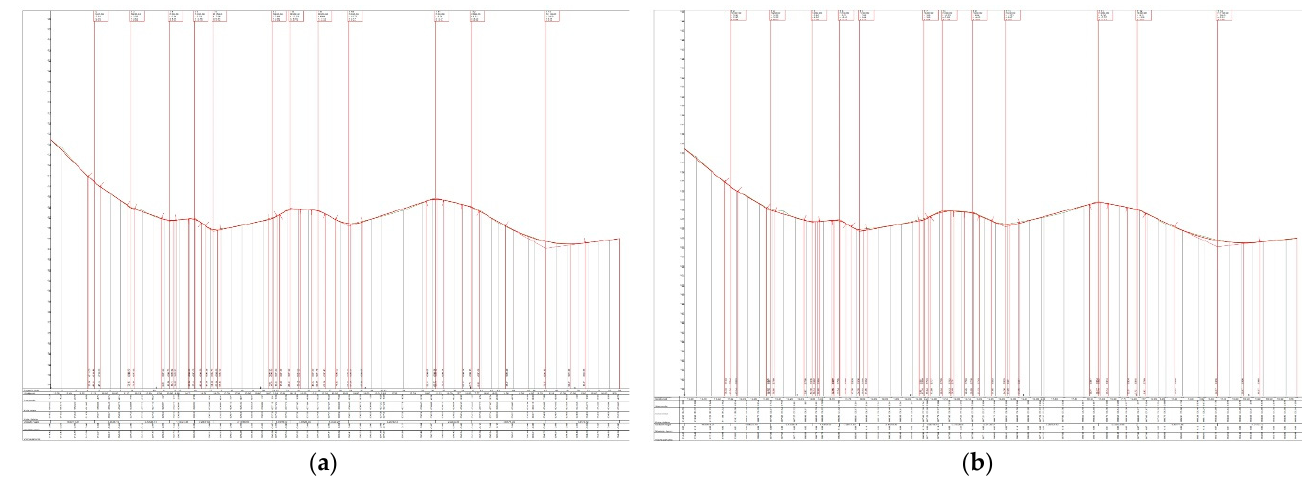
Figure 5. Results of the designed longitudinal level in software for designing forest/skid roads CESTA: ( a ) GNSS elevation points in profiles; ( b ) DTM elevation points in profiles. CESTA: ( a ) GNSS elevation points in profiles; ( b ) DTM elevation points in